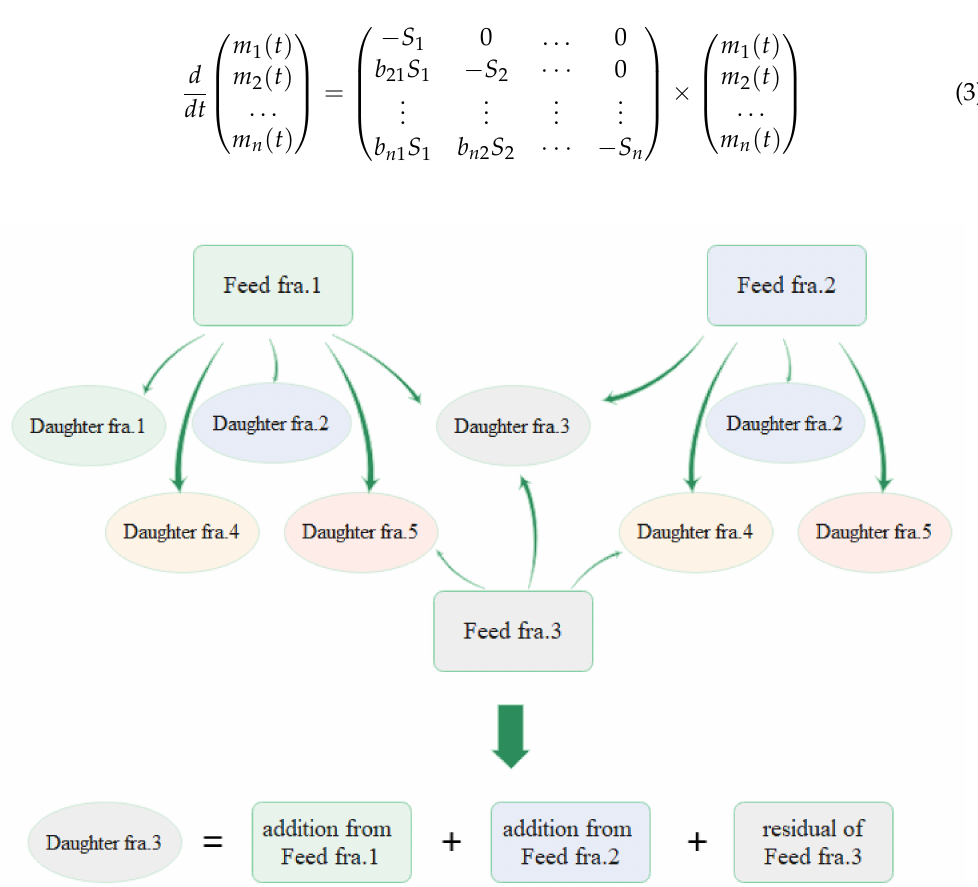
Figure 1. The logic diagram of the population balance